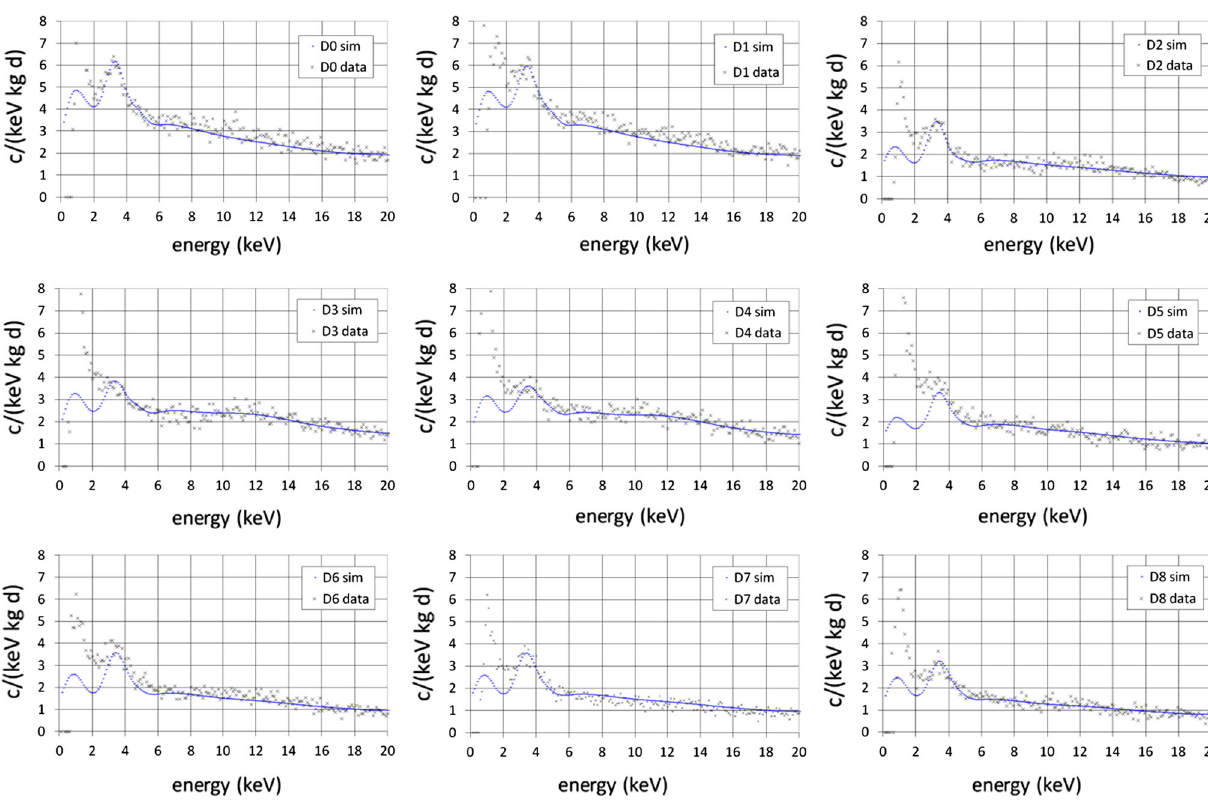
Fig. 11 Comparison of the anticoincidence energy spectra in the region of interest measured for each detector with the corresponding background modelsumming allthesimulatedcontributions. The shown